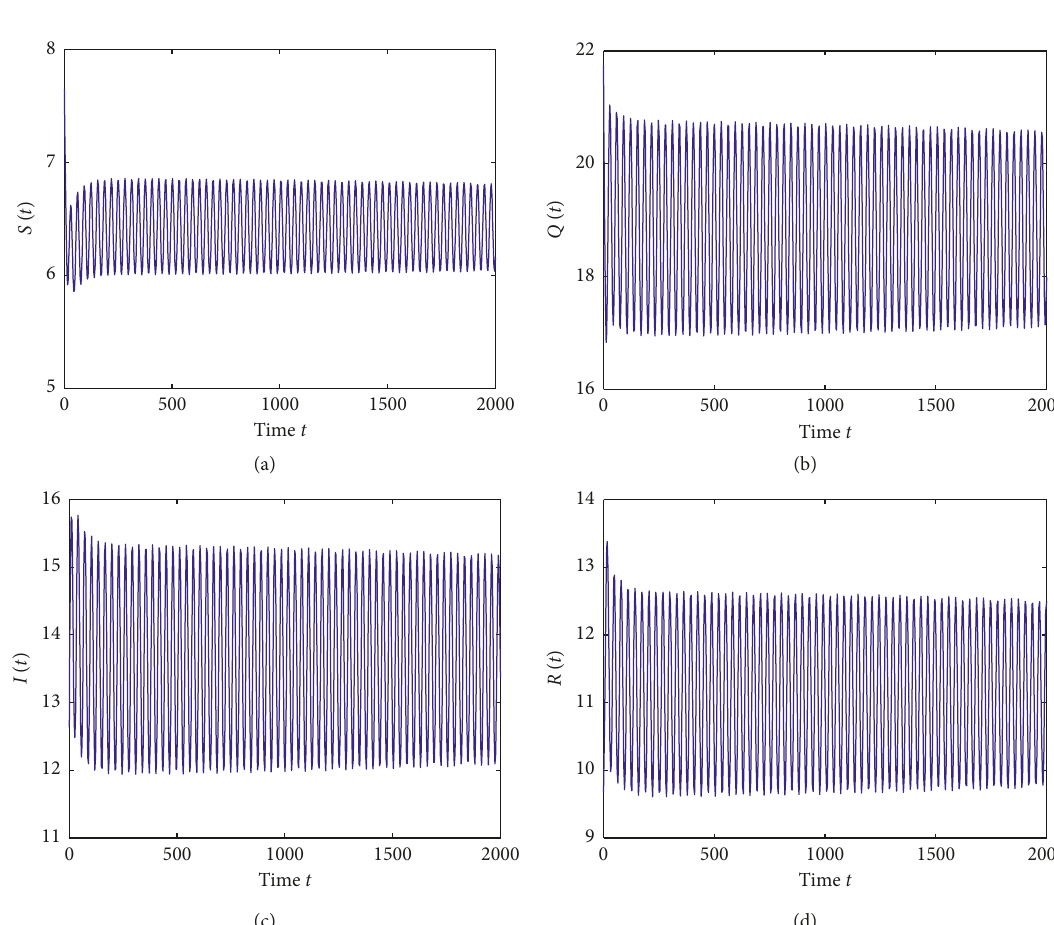
8 . 4565 τ 0 . (cid:31) <